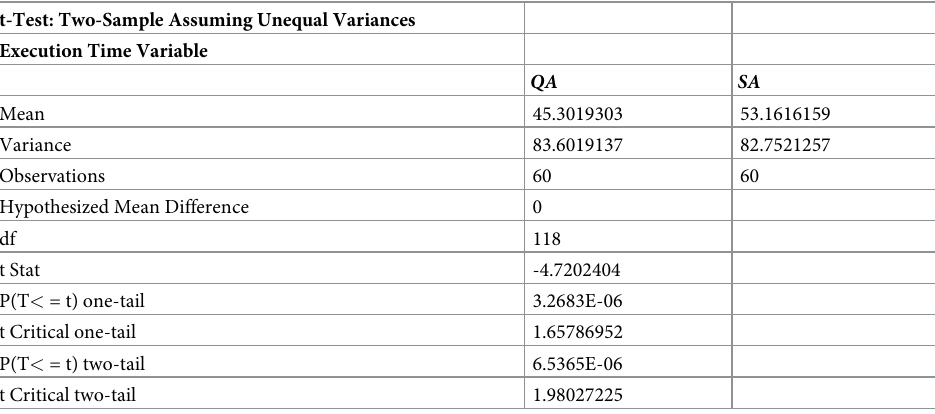
Table 19. T-test for n = 30 nodes and N = 60 trials—execution time variable. t-Test: Two-Sample Assuming Unequal